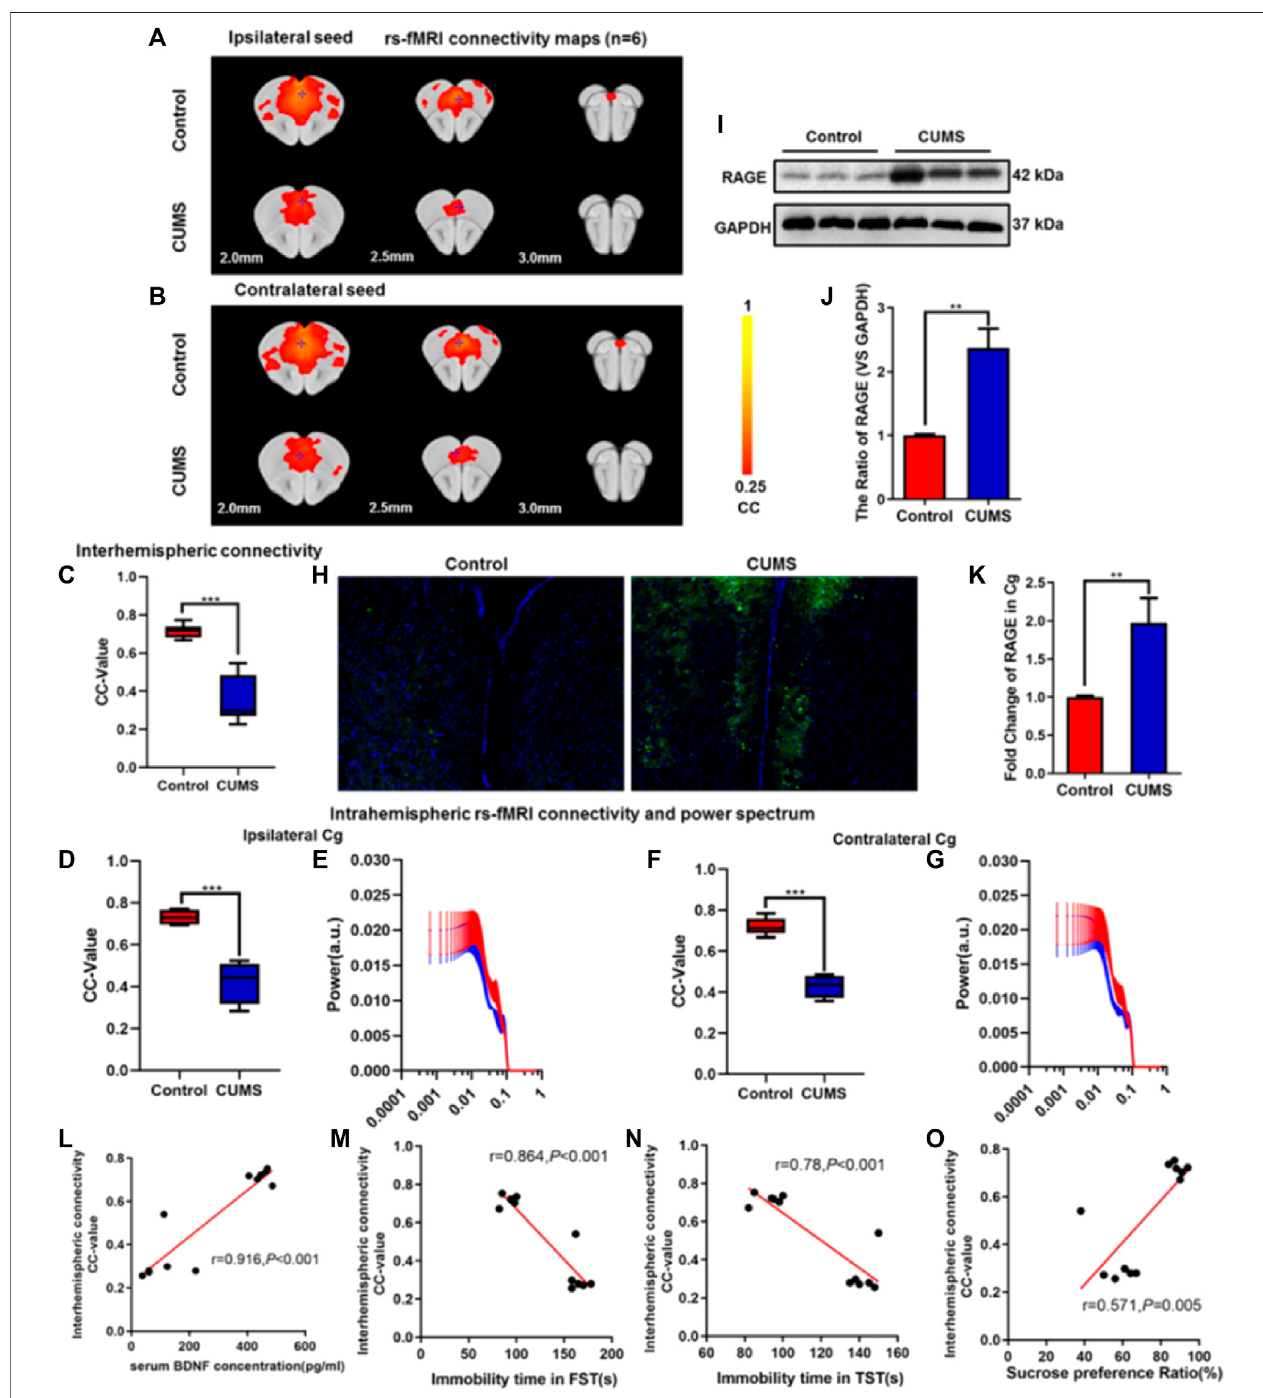
FIGURE 2 | Effect of chronic stress on functional connectivity (FC) of cingulate gyrus (Cg) in depressive-like mice. (A – B) Rs-fMRI connectivity maps of Cg in two groups of mice: ipsilateral seed (A) and contralateral seed (B) . (C) Quanti fi cation of interhemispheric rs-fMRI connectivity. (D – G) Quanti fi cation of intrahemispheric rs- fMRIconnectivity (D,F) andtherespectivepowerspectrum (E,G) ofipsilateralandcontralateralCgin4groupsofmice. (H) Immuno fl uorescenceexpressionofRAGEin the Cg of mice. (I – J) Western blot and semi-quantitative results of RAGE in the Cg of mice. (K) The mRNA fold change of RAGE in Cg of mice was detected by qPCR. (L – O) Relationship betweeninterhemisphericconnectivityCC-valueandBDNF (L) expressioninserum anddepressive-likebehavior[FST (M) ,TST (N) ,andSPT (O) ] in mice. The data are presented as mean ± SEM. Two sample T-test. Rs-fMRI maps generated by correlation analysis of band-pass fi ltered (0.005 – 0.1 Hz) BOLD signals using a seed de fi ned in the ipsilateral and contralateral side. Seed location is indicated by a blue crosshair. Quanti fi cation of the interhemispheric rs-fMRI connectivity ( n (cid:1) 6). ** p < 0.01, *** p < 0.001. CUMS group vs. Control group.